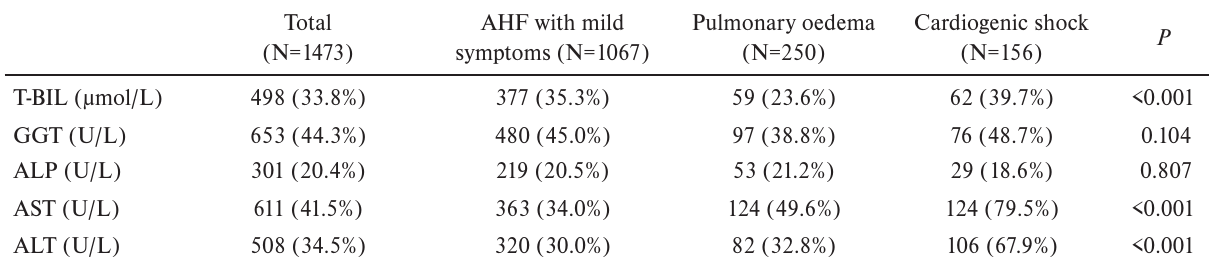
Table 3. Percentages of abnormal LFTs according to types of AHF.